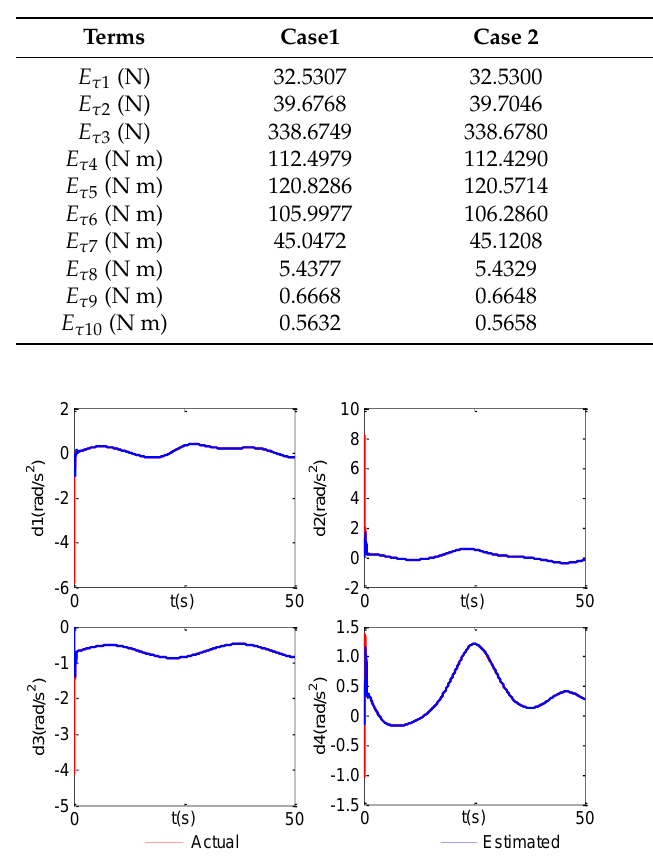
Table 6. Average force and moment values of the UVMS under four cases from 10 s to 50 s.